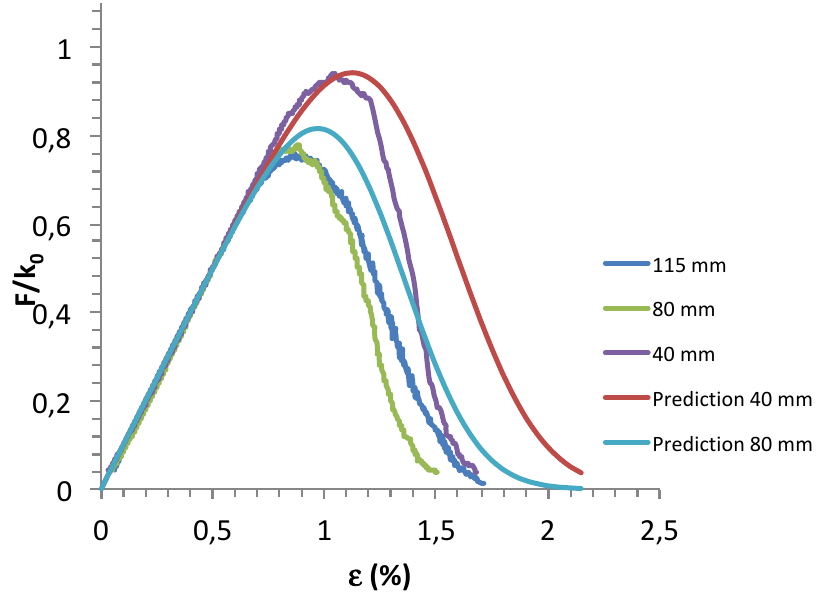
Figure 11. Comparison of experimental F / k 0 curves with predictions using Equation (8) and normal distribution function.